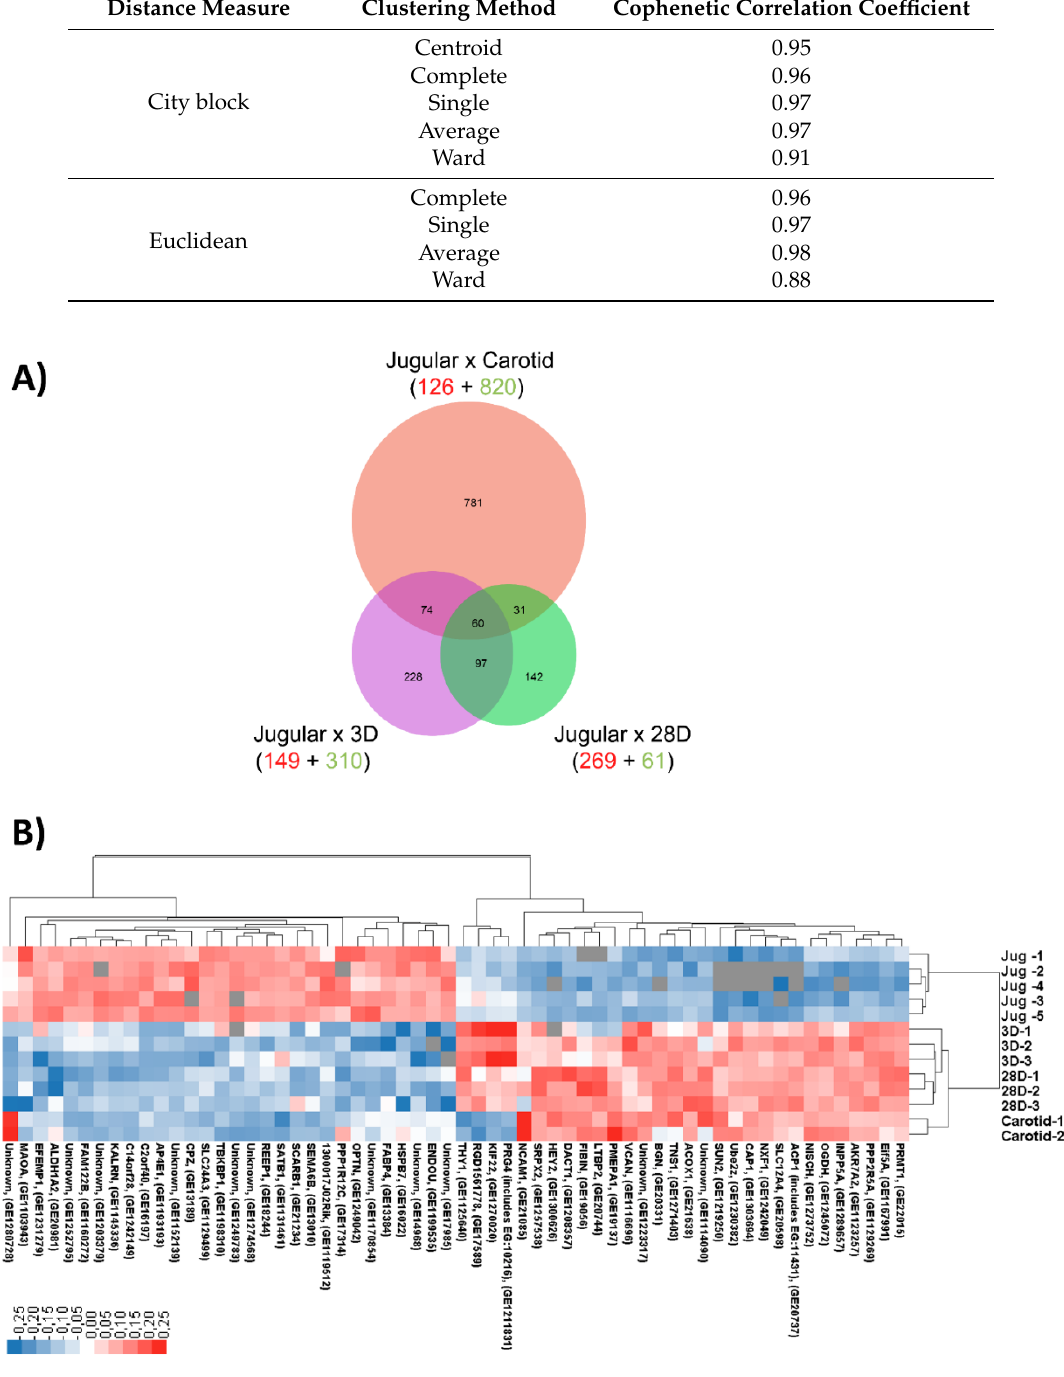
Table 1. Cophenetic correlation coefficient for different clustering strategies. The closer the values are to 1, the closer they are to the original distances. Different methods of clustering analysis revealed similar results.